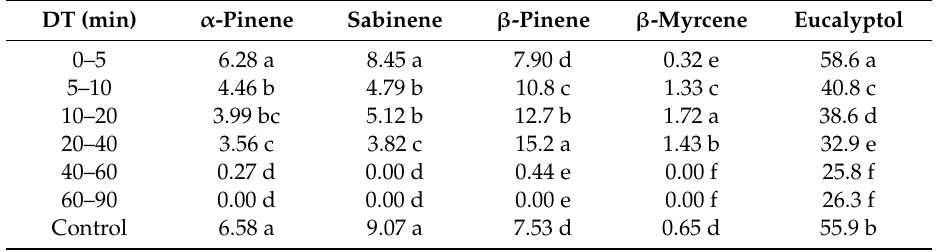
Table 7. Mean concentrations (%) of Hyssopus officinalis subsp. aristatus EO ( α -pinene, sabinene, β -pinene, β -myrcene, and eucalyptol) obtained from the seven distillation times (DT). Control = nonstop 0–90